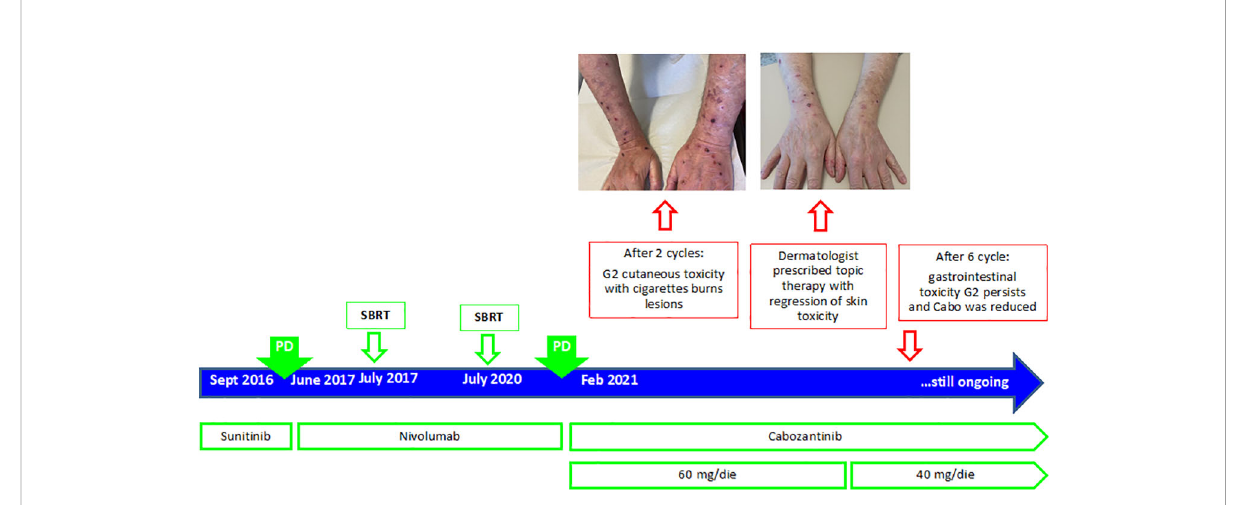
FIGURE 6 Timeline management of cardiovascular toxicity in the course of ICI- and TKI-based